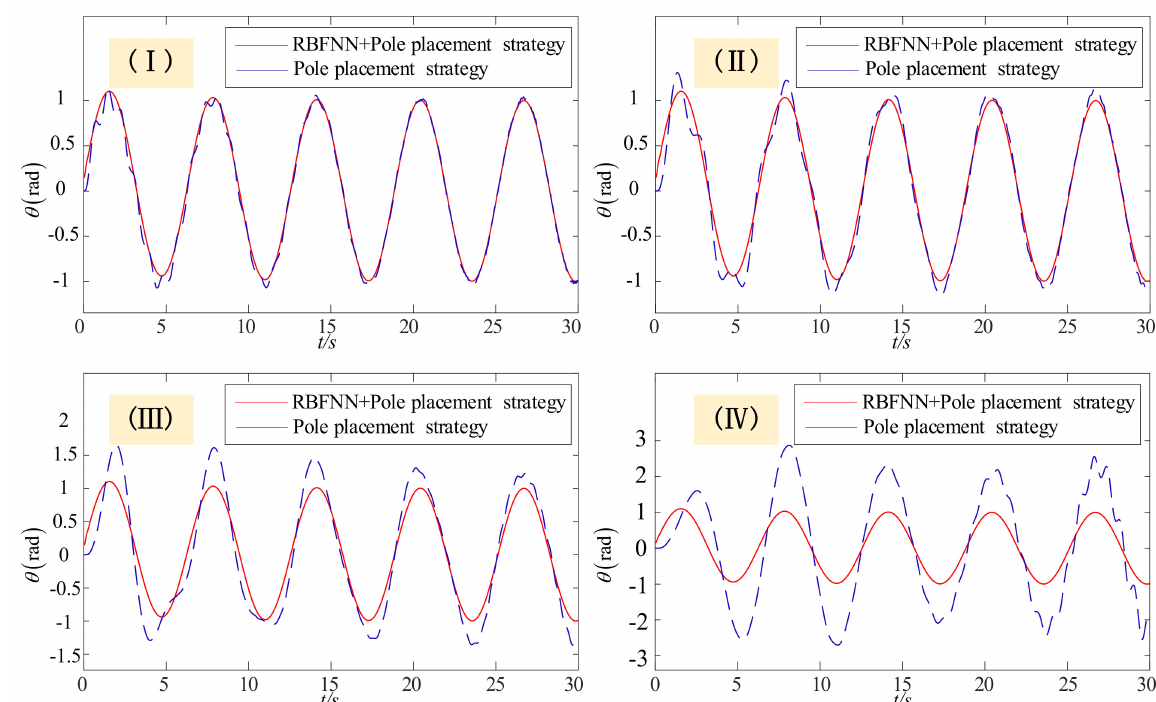
Figure 12. The simulation result of rotation angle. ( I ) Condition1. ( II ) Condition2. ( III ) Condition3. ( IV ) Condition4.